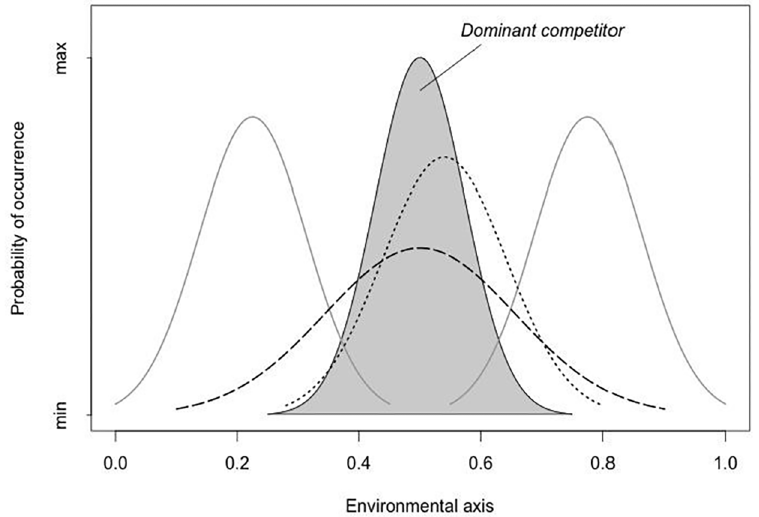
Fig 1. Characteristic of niches for dominant and subordinate species. Graphical representation of characteristics of niches for dominant (shaded area) and subordinate (non-shaded areas) competitors, when interference competition is present. The dominant species would occupy the space that suits its requirements and its niche position and breadth would be determined by the characteristics of the environment (i.e., their fundamental and realized niches would coincide). The subordinate species in the presence of the dominant one, and when interference competition is present, would change its niche to partially or totally avoid competition (encounters in our case) with the dominant species, which would result in wider niche breadth, displaced with regard to its theoretical centre, or even bimodal niches with separate peaks. Thus, when estimating niche parameters over several study areas for the jaguar-puma pair, it is expected that pumas (the subordinate or less competitive species) will present greater variability of parameters (niche centre and/or breadth) than